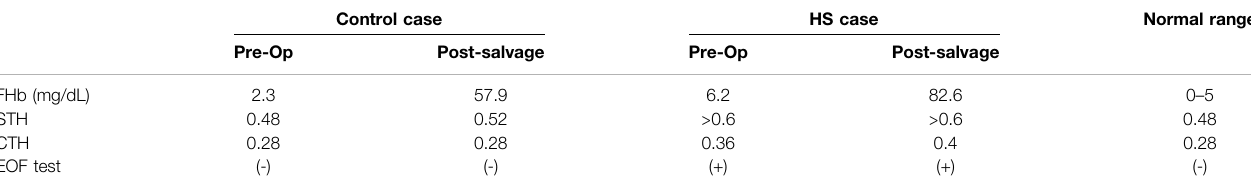
TABLE 1 | Comparative hemolysis-related test results of the HS patient and control patient. Control case HS case Normal range Pre-Op